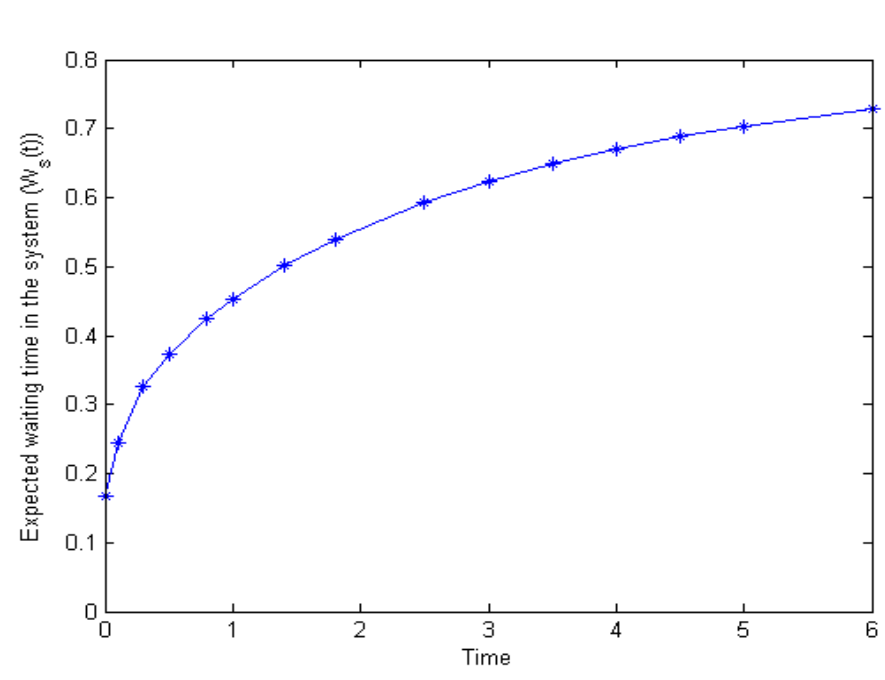
Figure 3. Expected waiting time in the system vs.